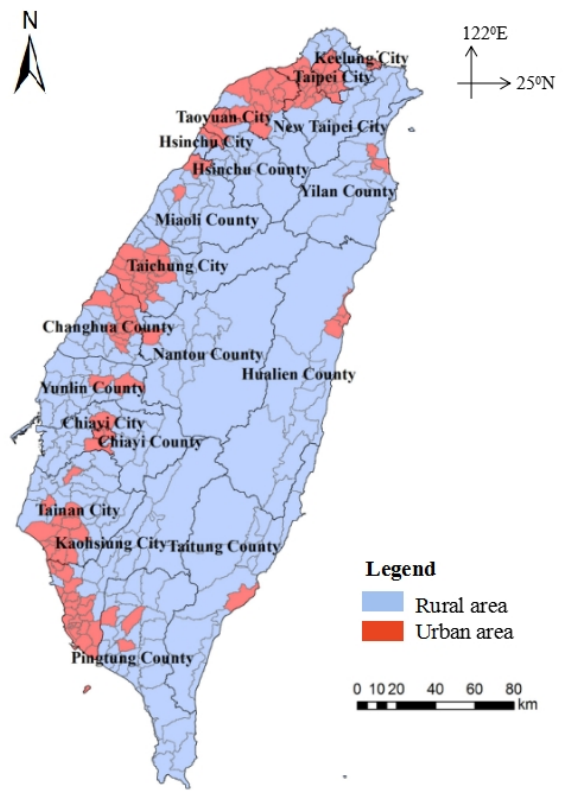
Figure 1. The research scope of ecological governance of urban–rural coupling.